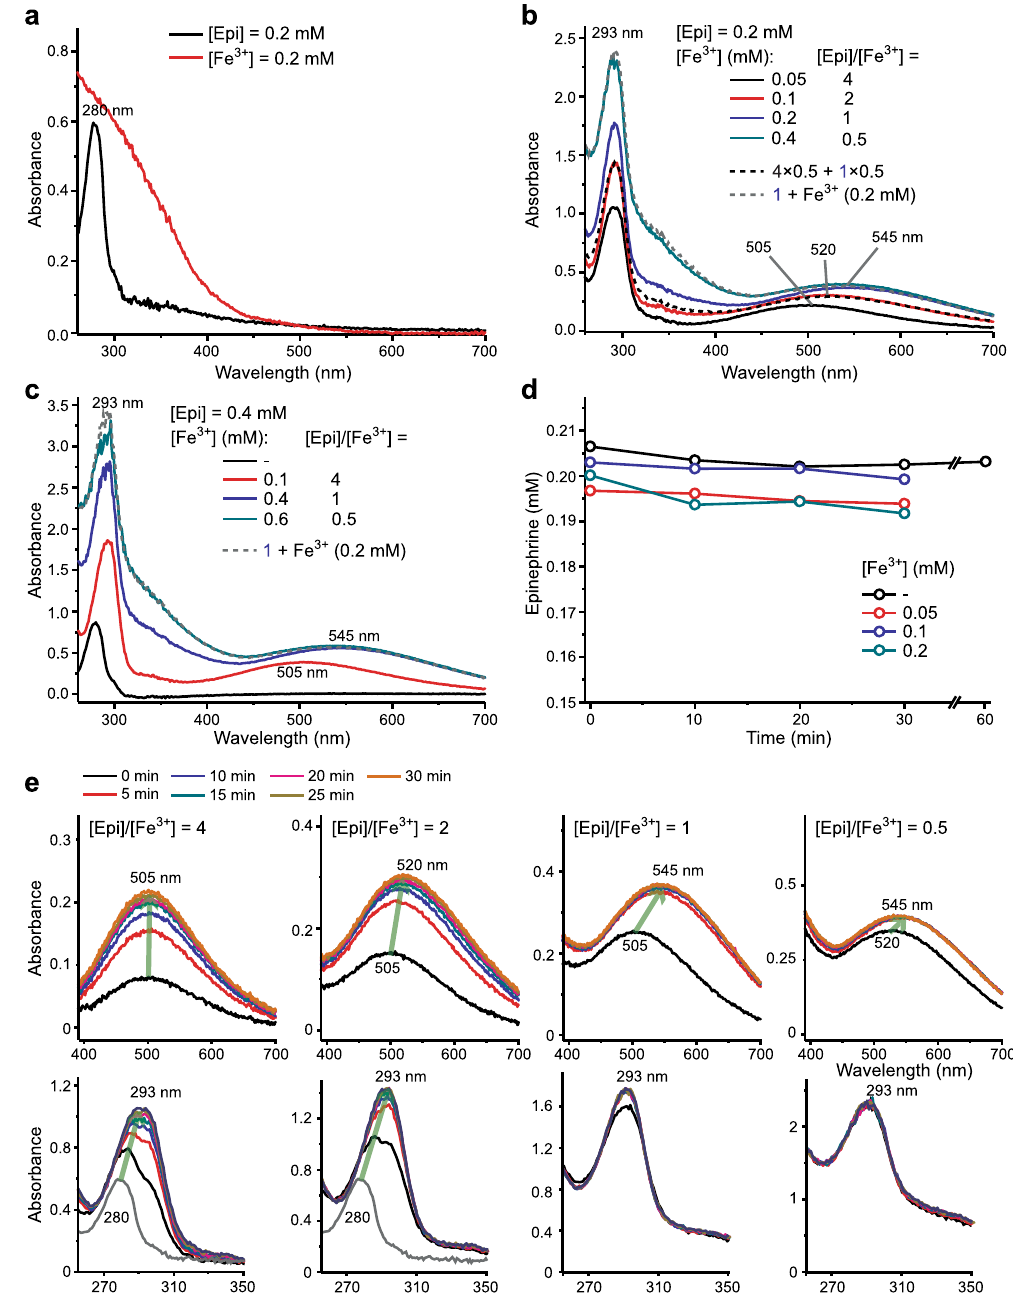
Figure 1. UV/Vis spectra of Epi and ferric iron in 10 mM Tris buffer, pH 7.4. ( a ) 0.2 mM Epi and 0.2 mM Fe 3 + . ( b ) 0.2 mM Epi in the presence of 0.05, 0.1, 0.2, or 0.4 mM Fe 3 + (30 min incubation). Dashed lines represent sums of experimental spectra for different [Epi]/[Fe 3 + ] = 4 and [Epi]/[Fe 3 + ] = 1 (divided by 2; dark); and for [Epi]/[Fe 3 + ] = 1 and free [Fe 3 + ] = 0.2 mM (pale). ( c ) 0.4 mM Epi in the presence of 0.1, 0.4 or 0.6 mM Fe 3 + (30 min incubation). The dashed lines represent the sum of experimental spectra for [Epi]/[Fe 3 + ] = 1 and free [Fe 3 + ] = 0.2 mM. ( d ) Stability of Epi in the presence of Fe 3 + , measured by HPLC. ( e ) Changes in UV/Vis spectra for different [Epi]/[Fe 3 + ] ratios, during a 30 min incubation period. In all systems [Epi] = 0.2 mM. For clarity, the ranges 400–700 nm and 260–350 nm (gray line represents absorption from Epi only) are shown